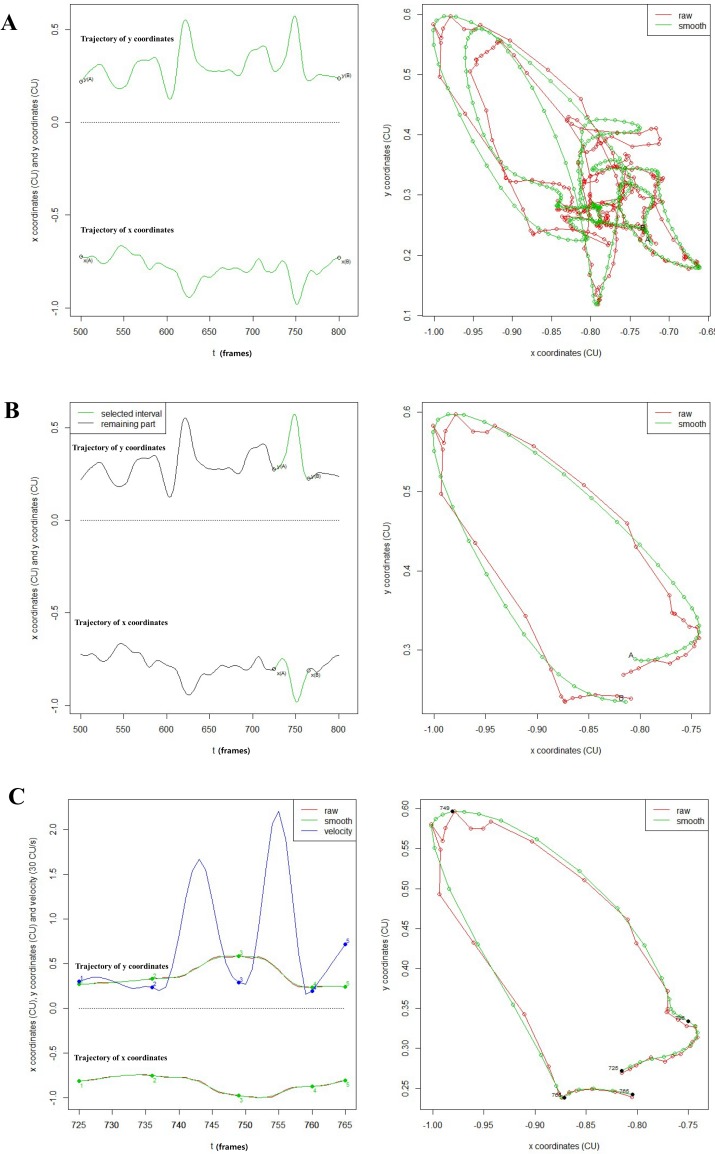
Example of automatic segmentation for one non-aspiration case.A. The curves of the x coordinates and y coordinates of all the data (the left panel) and the entire 2D trajectory (the right panel): the dots connected with a line in red show the raw trajectory just after being calibrated while the ones in green represent smoothing data after calibration. B. Extracted one loop based on the two cutting points A and B (the left panel) from the entire trajectory and the corresponding 2D trajectory(the right panel). C. Automatically segmenting the trajectory into four phases. The upper curve in green in the left panel stands for the smoothing y coordinates and the lower one for the smoothing x coordinates, together with the curves in red representing raw data. The curve in blue represents the velocity amplitude v(t), where t represents the video frame sequence and the numbers in different colours stand for splitting points’ order. The right panel shows the segmentation results in 2D trajectory.